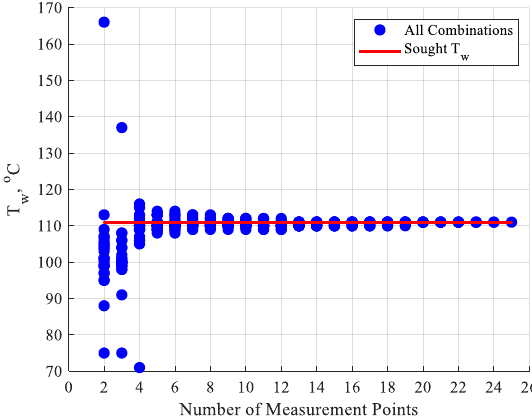
Figure 5. Influence of total numbers of measurement points for searching the wire temperature.